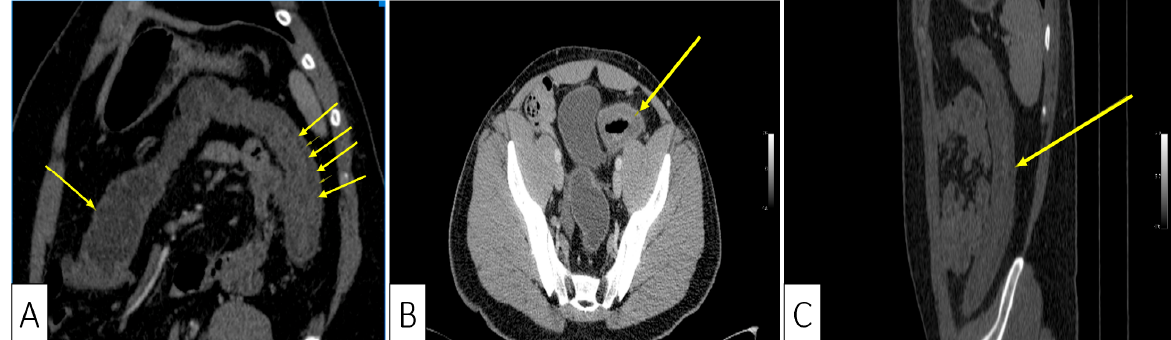
Figure 3. Abdominal CT showing: ( A ) Coronal plane, oblique reconstruction image showing the difference between the normal wall (single arrow at the transverse colon) and the thickened pathological wall of the left colon (multiple arrows); ( B ) Axial plane, venous phase, showing stratified wall thickening of the proximal sigmoid; ( C ) Sagittal plane, showing the left colonic involvement with symmetrical wall thickening.